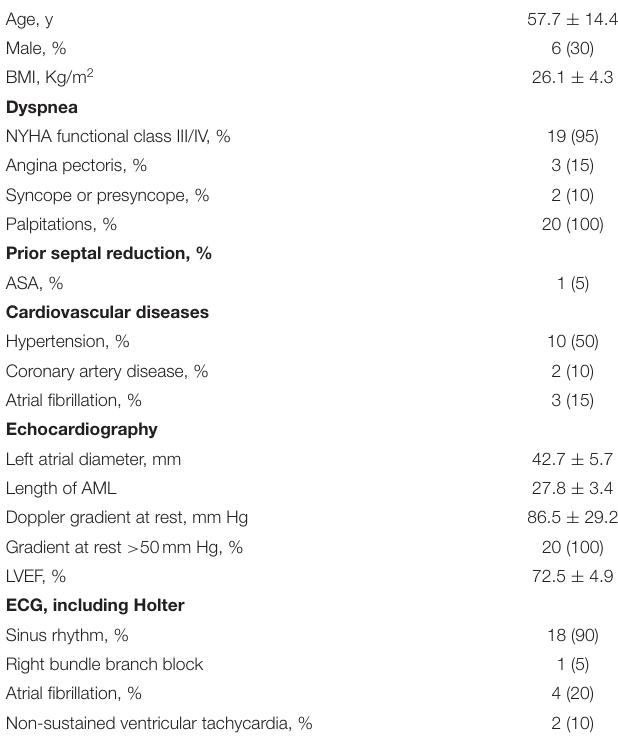
TABLE 1 | Baseline characteristics ( n =